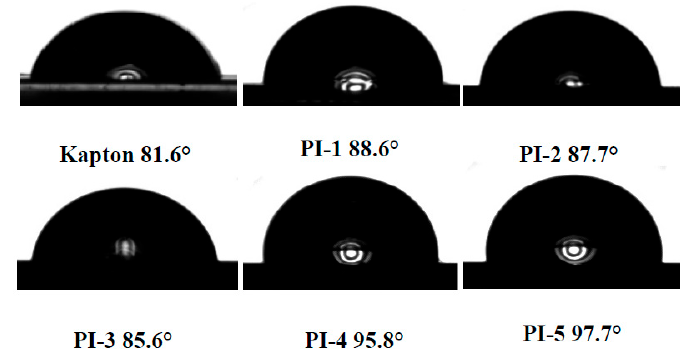
Figure 5. The contact angle of Kapton and Polyimide films.